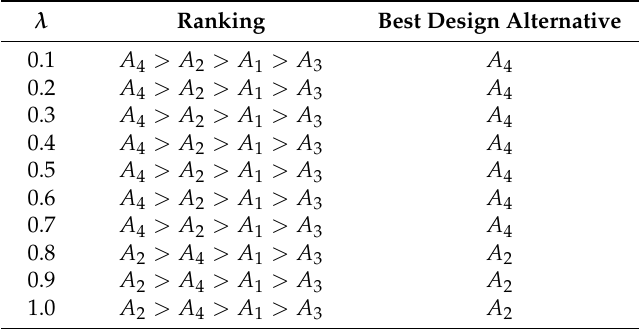
Table 5. The rankings of all design